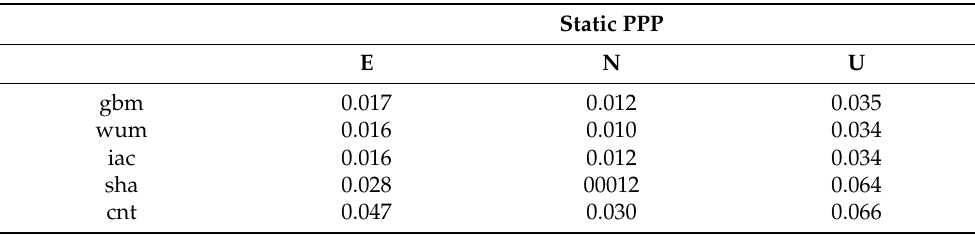
Table 7. The 75th percentile of positioning accuracy (unit: m) in ENU directions derived from BDS-3 PPP in static mode with different precise